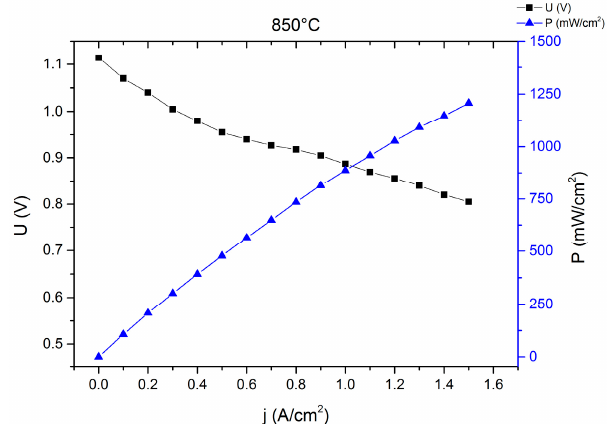
Figure 1. I–V curve of a planar 5 cm by 5 cm 2 single cell MSC with a 4 µm thin layer 8YSZ electrolyte, a Ni/8YSZ anode and an LSCF cathode at 850 °C in 3% humidified hydrogen after 10 h of in-situ a Ni/8YSZ anode and an LSCF cathode at 850 ◦ C in 3% humidified hydrogen after 10 h of in-situ activation. For more details about the manufacturing refer to Section 3. activation. For more details about the manufacturing refer to Section